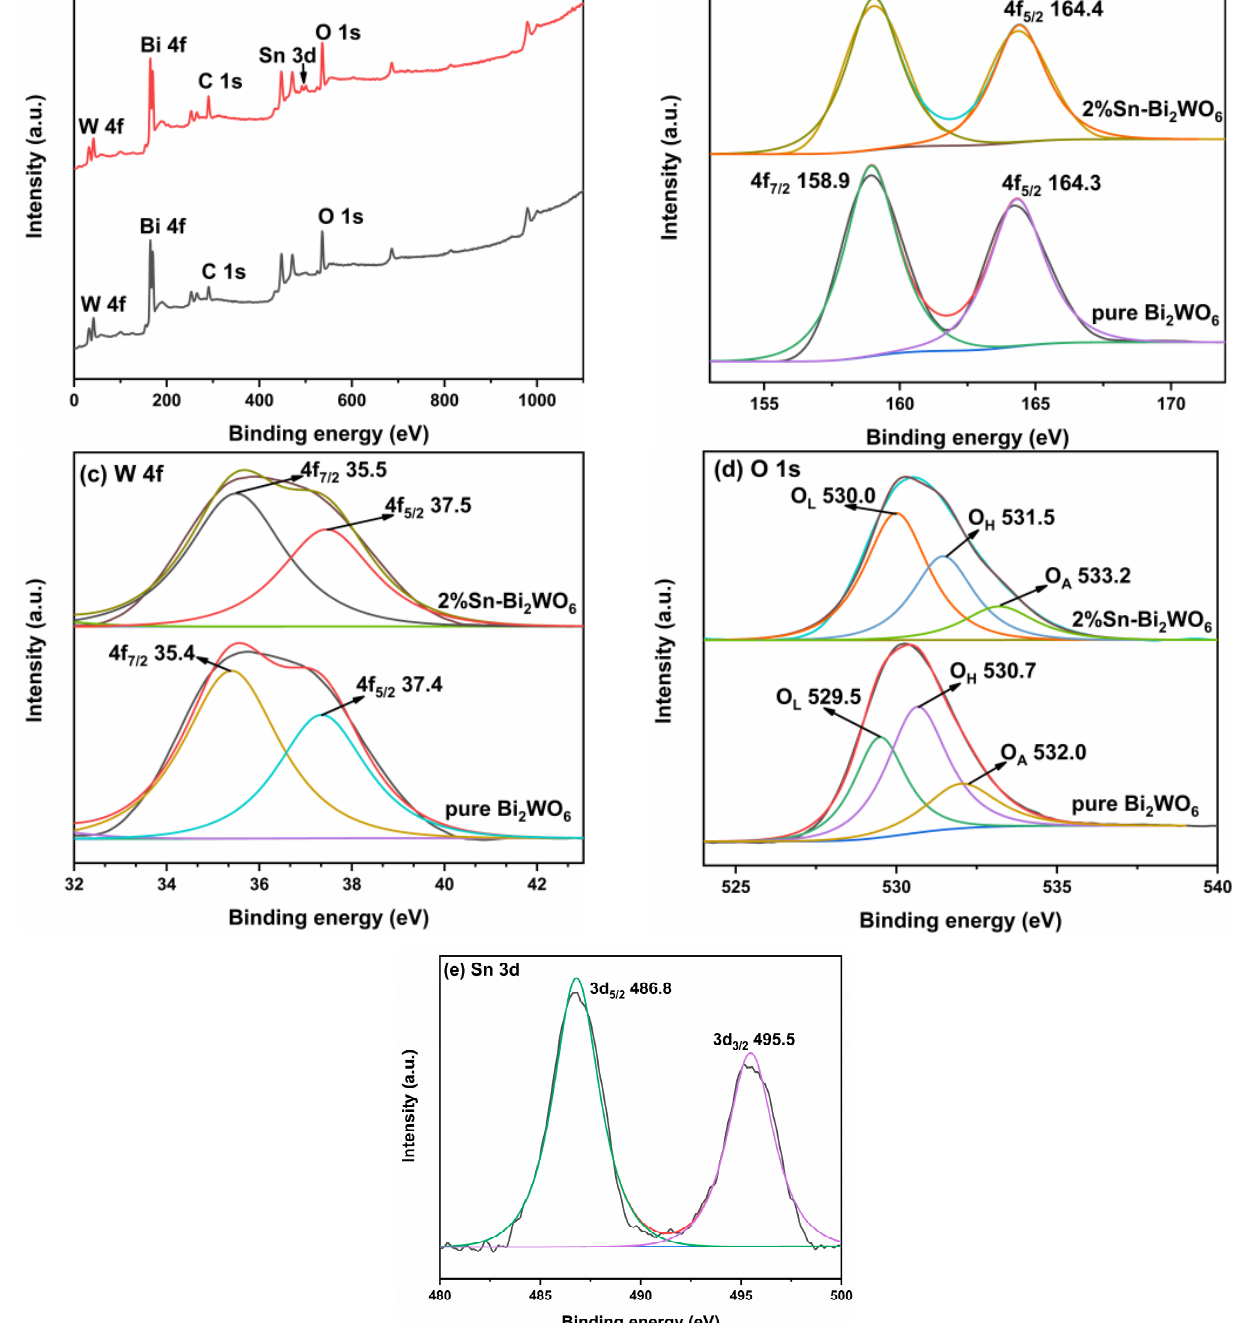
Figure 5. XPS survey of pure Bi 2 WO 6 and 2%Sn-Bi 2 WO 6 ( a ), high resolution spectra of Bi 4f ( b ), W 4f ( c ), O 1s ( d ), and Sn 3d ( e ). Table 2. Binding energies of samples.